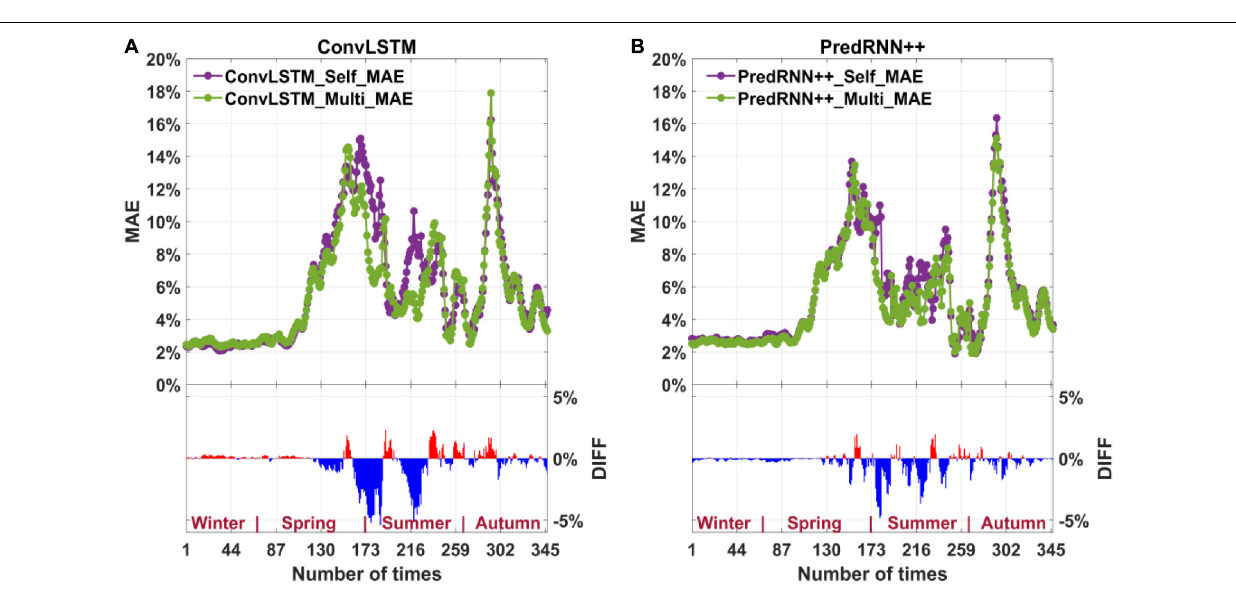
FIGURE 6 | MAE for single-factor and multi-factor ConvLSTM predictions based on MAE-loss (A) and MAE for single-factor and multi-factor PredRNN++ predictions (B) . The DIFF in the bar graph is obtained by subtracting the single-factor model from the multi-factor model. The red color represents the positive value, and the blue color represents the negative